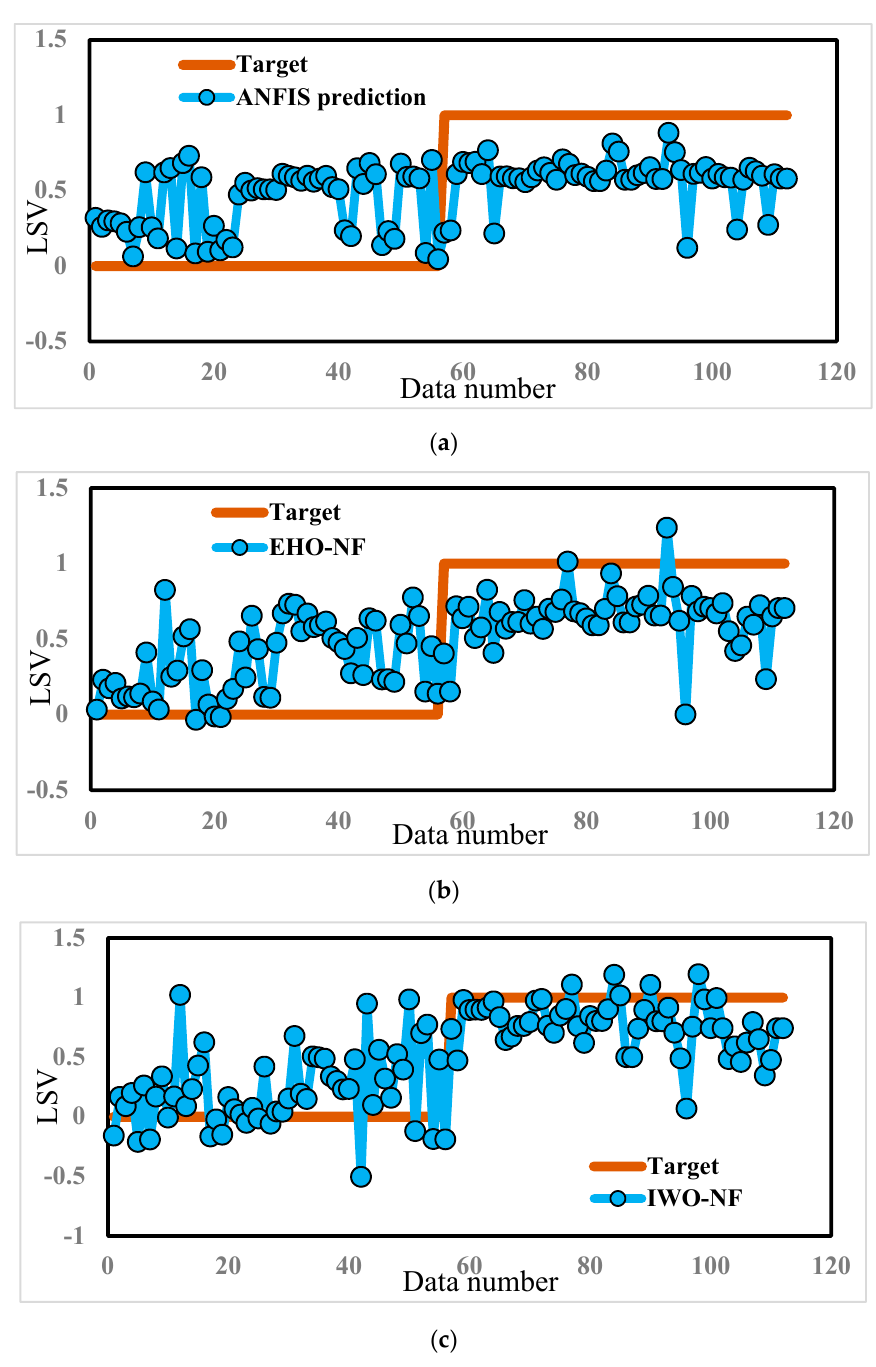
Figure 5. The results obtained by ( a ) typical ANFIS, ( b ) EHO-NF, and ( c ) IWO-NF for the whole dataset.